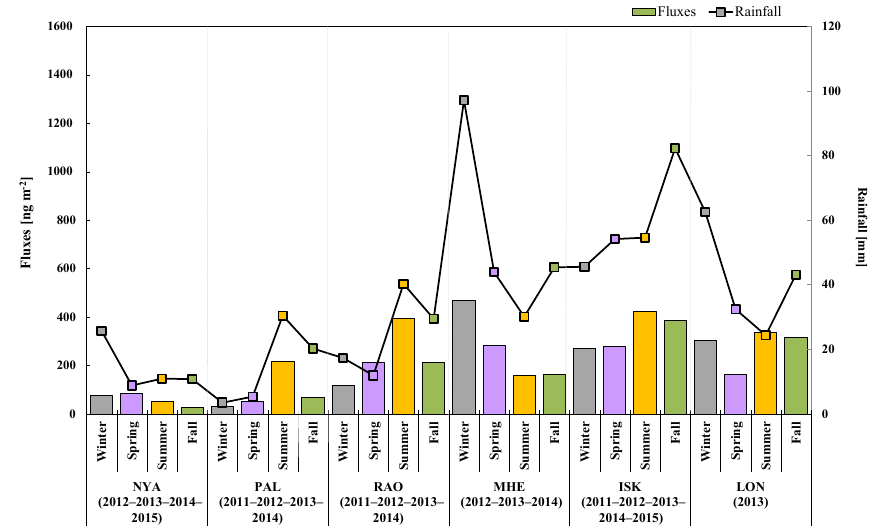
Figure 5. Seasonal mean values distribution of sampling-weighted (by 15-day reference) fluxes and rainfall at the European GMOS sites from 2011 to